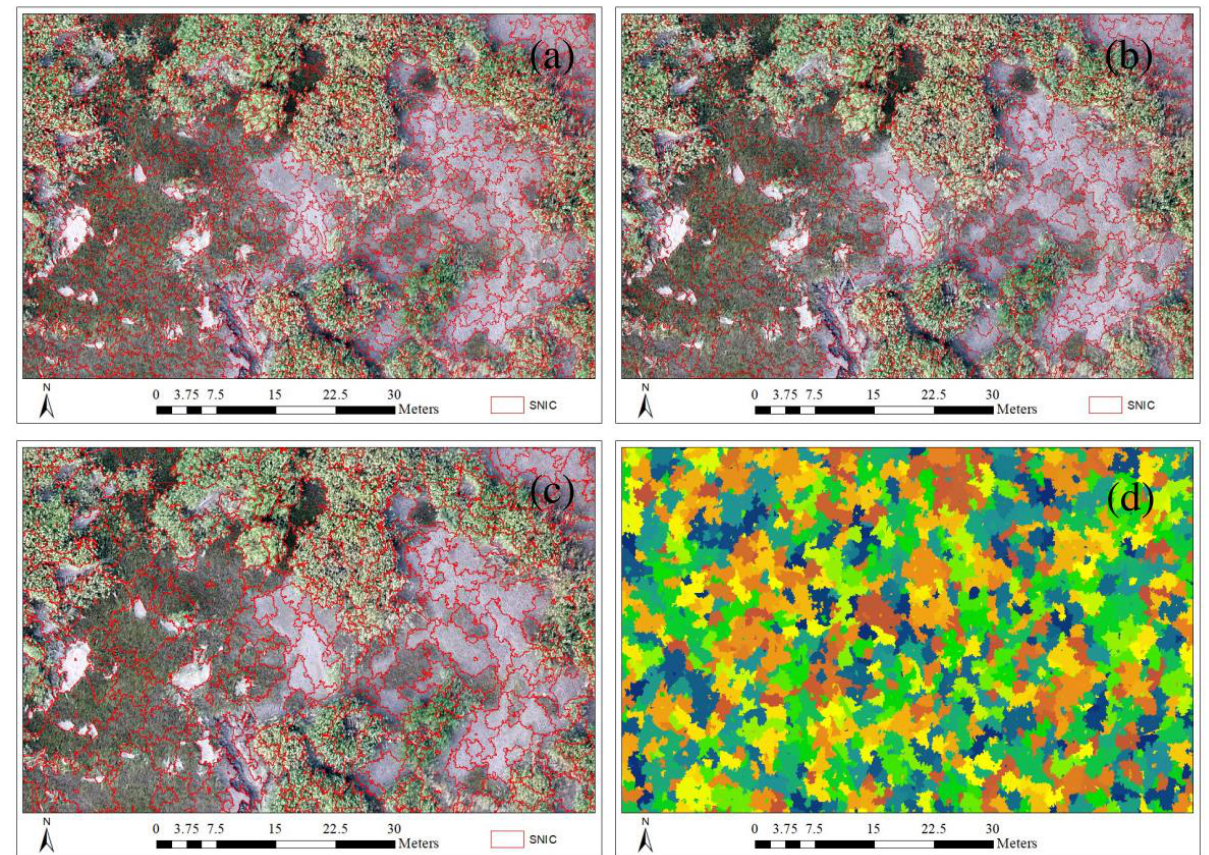
Figure 3. The results of SNIC image object segmentation using different parameters based on GEE. ( a ) seedGrid parameter of 36, ( b ) seedGrid parameter of 48, ( c ) seedGrid parameter of 60, and ( d ) raster generated directly in the SNIC algorithm in GEE.